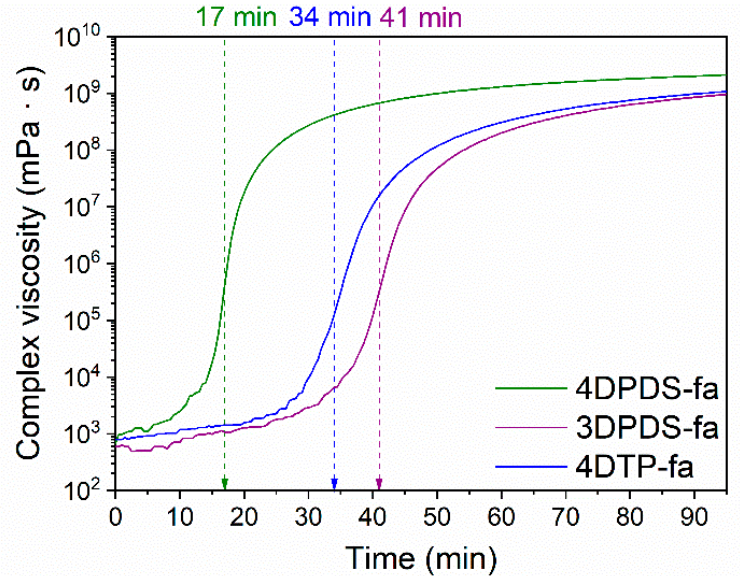
Figure 3. Curing behavior of diBz by rheo-kinetics measurement at 150 °C followed by complex viscosity measurement over time.